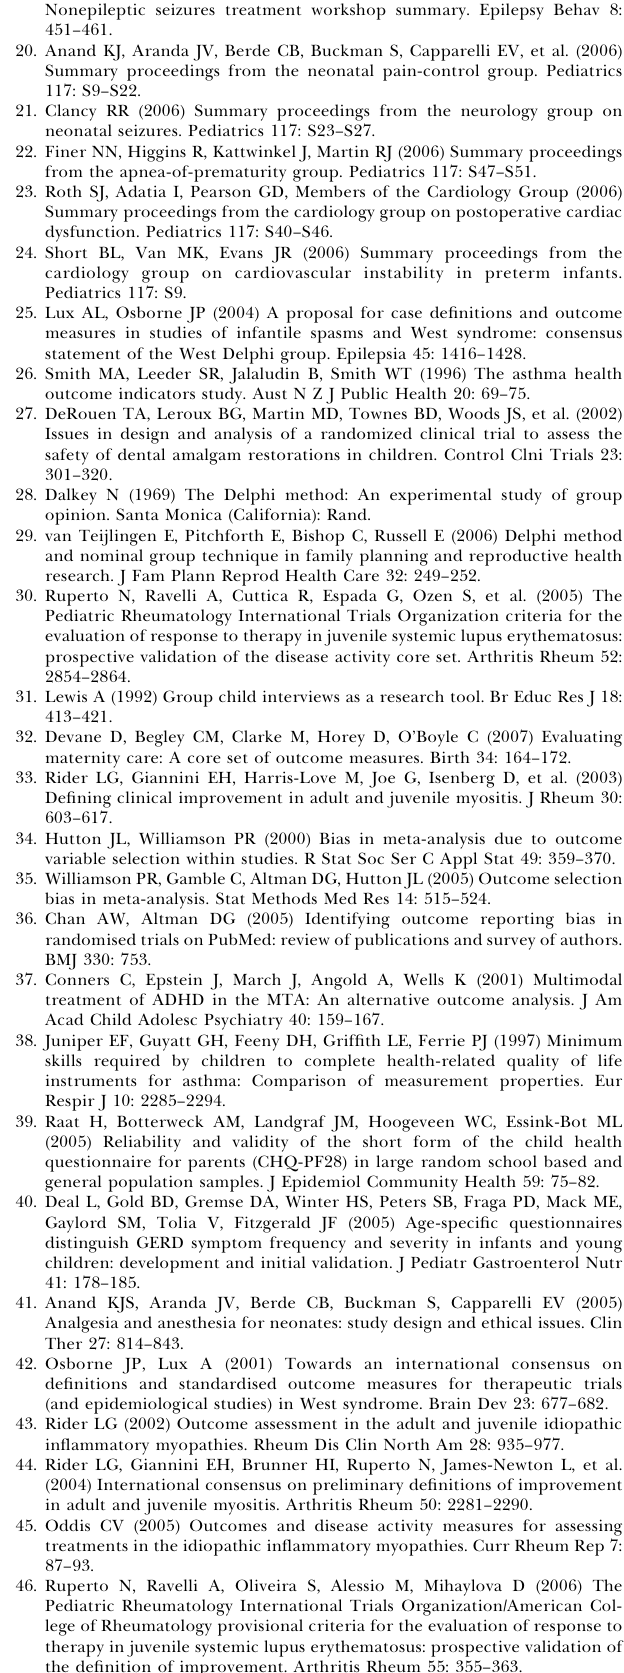
Table S4. Critical Appraisal of the Methodological Quality of Included Studies Found at doi:10.1371/journal.pmed.0050096.st004 (110 KB DOC). Table S5. Outcomes Selected for Use in Clinical Trials in